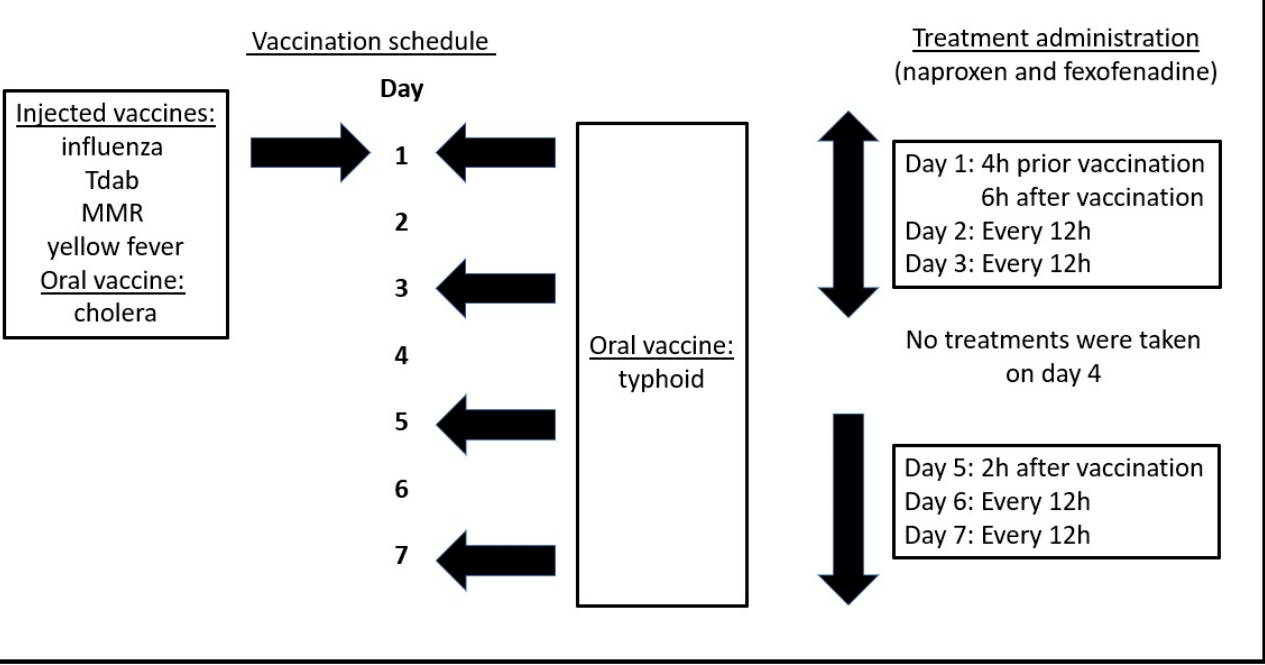
Figure 1. Vaccination schedule and treatment administration. Abbreviations: Tdab = tetanus toxoid, reduced diphtheria toxoid, and acellular pertussis, MMR = measles, mumps, and rubella.